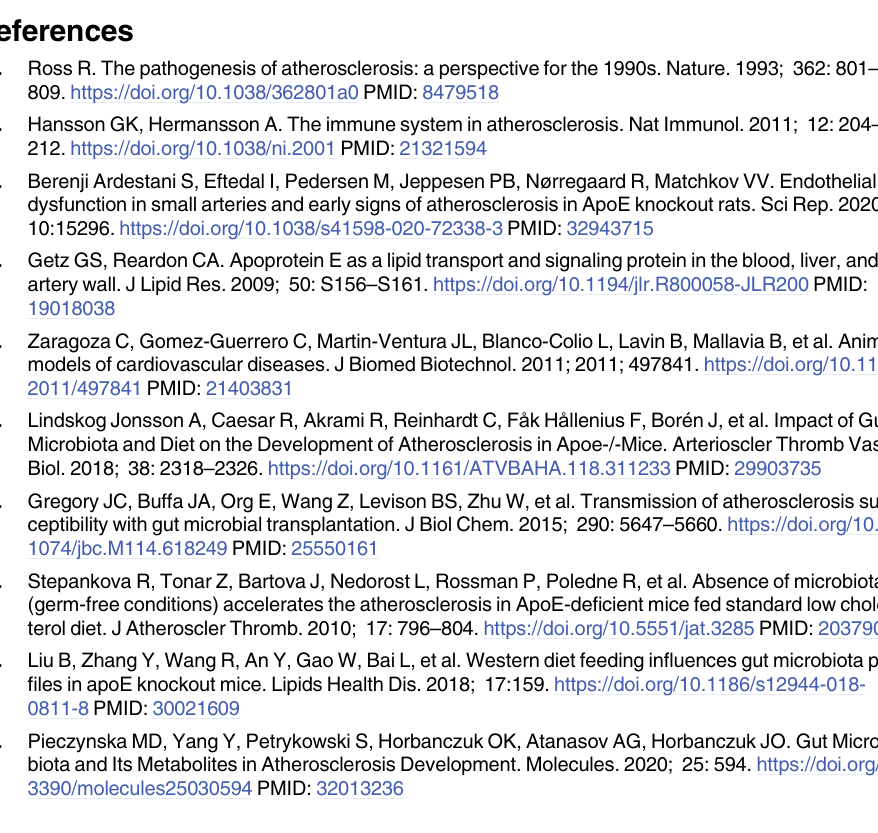
S1 Fig. The CD31 immunohistochemical staining of thoracic aorta lesions. GF: germ free, SPF: specific pathogen free. (TIF) S1 Data. The raw data of metabolites between the GF- and SPF-ApoE -/-